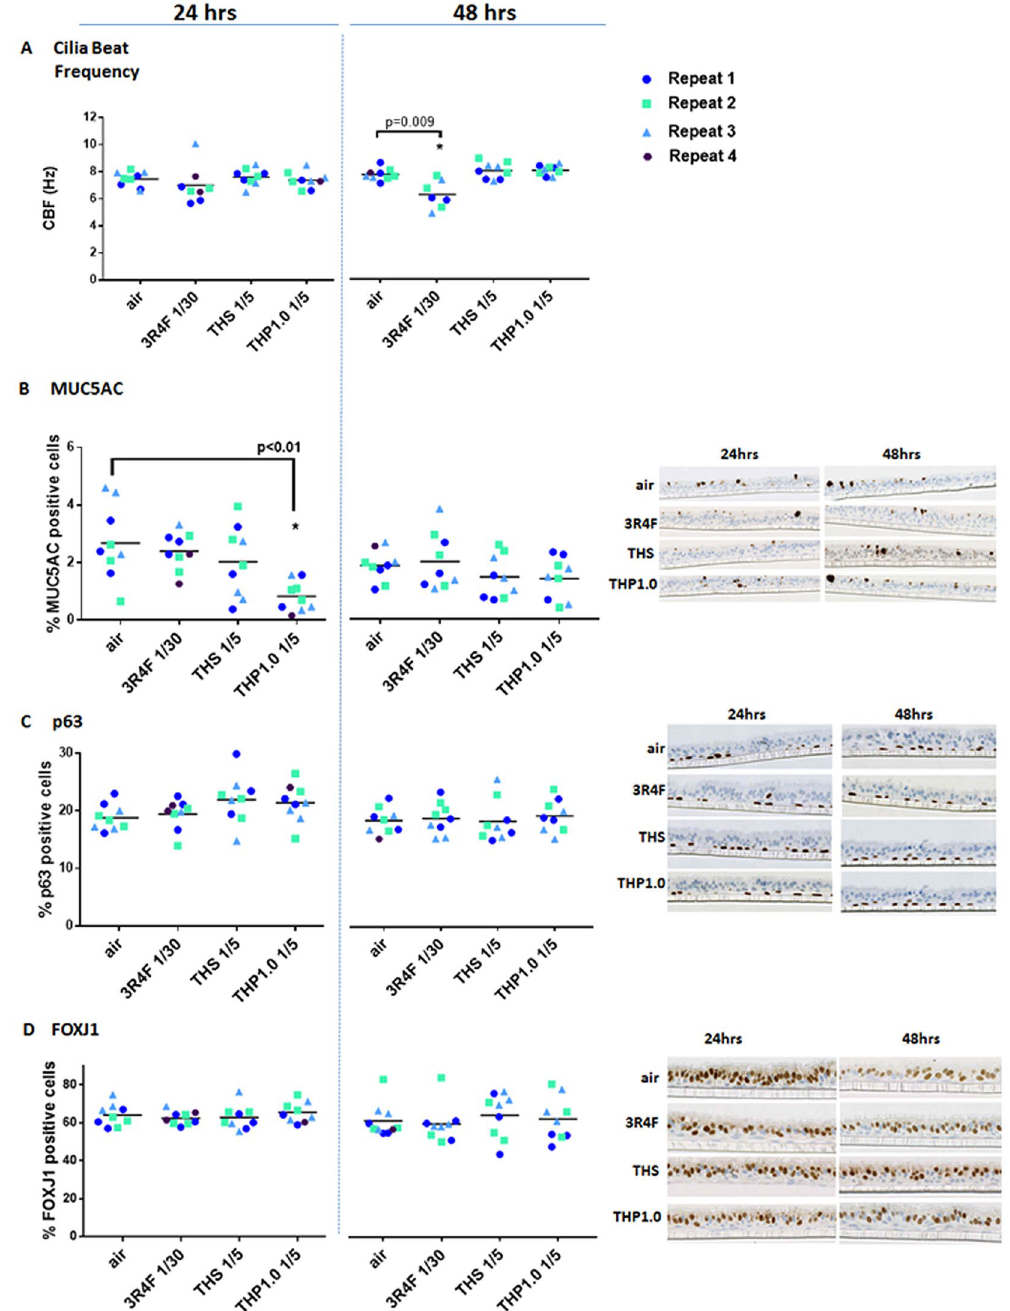
Figure 3. MucilAir ™ functional and morphological endpoints after exposure to air, 3R4F smoke, THP1.0 and THS aerosols. Cilia beat frequency (Hz) scatter plots at 24 hrs and 48 hrs post-treatment ( A ). Scatter plots for MUC5AC ( B ), p63 ( C ) and FOXJ1 ( D ) quantitative immunohistochemistry at 24 and 48 hrs post exposure. Values from each independent exposure repeat are labelled with a different color. The mean CBF, MUC5AC, p63 and FOXJ1 values for each treatment is shown by the black horizontal line. * Denotes a t-test significance at p < 0.05 using the air control as comparator. Representative micrographs are shown in ( B , C and D ) for the MUC5AC, p63, and FOXJ1 immunohistochemistry,